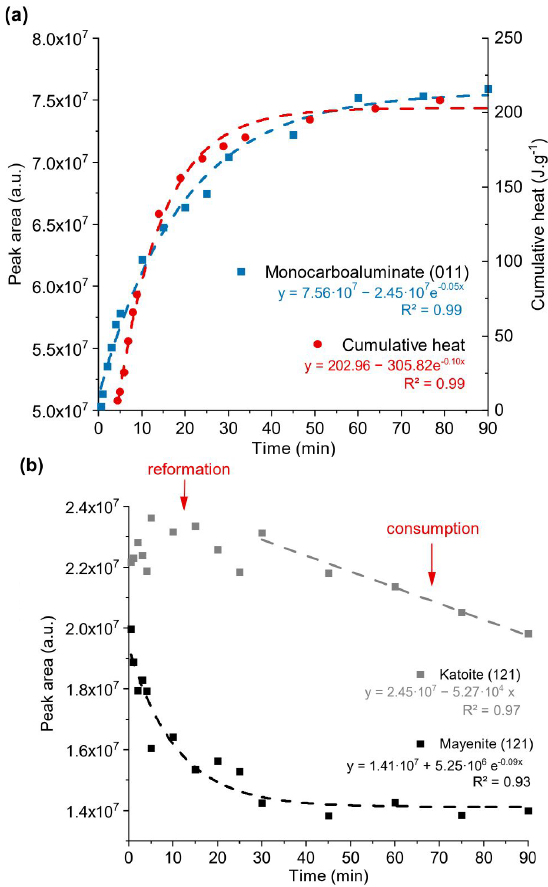
Figure 5. Peak area of monocarboaluminate (011) (left Y) and cumulative heat (right Y) versus time (a), and peak areas of katoite (121) and mayenite (121) versus time (b). Please note the differences in scale.